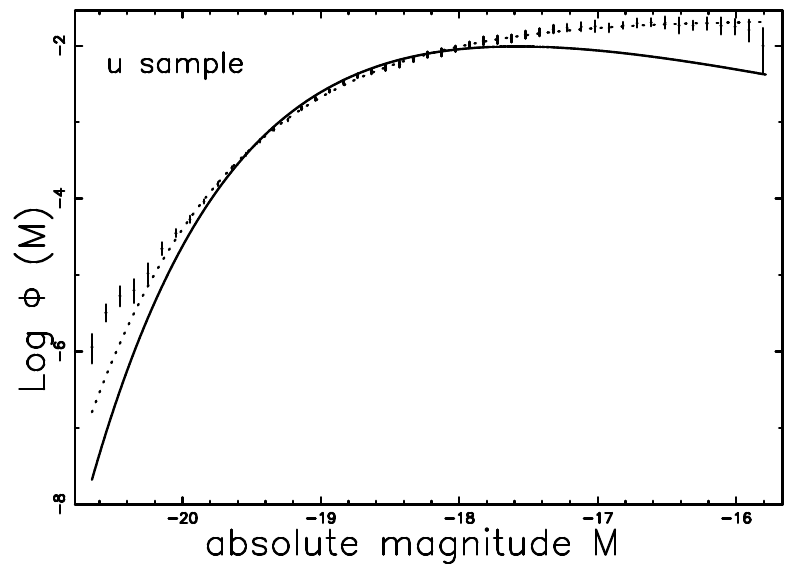
Figure 5. The luminosity function data of SDSS( u ∗ ) are represented with error bars. The continuous line fit represents the Lindley LF (33) and the dotted line represents the Schechter